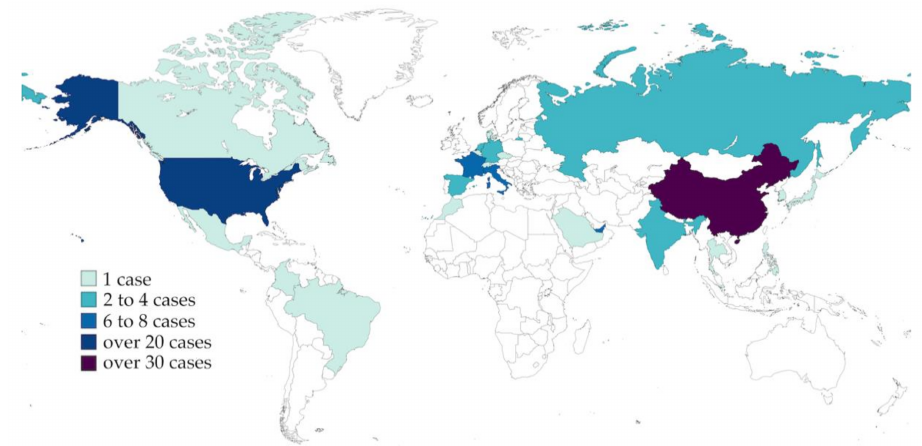
Figure 4. Map of 3D-printed constructions by country.